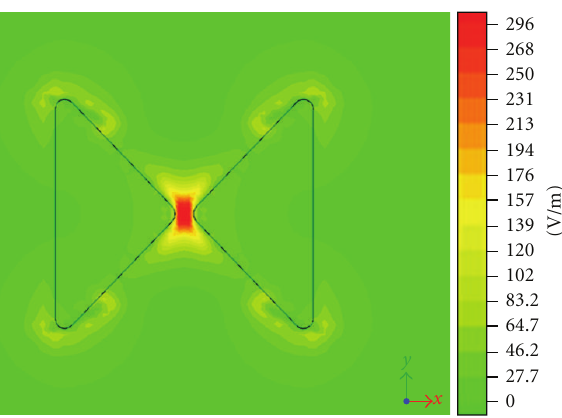
Figure 6: Electric field distribution on 90 ◦ bowtie antenna at 172.5 THz due to x -polarized plane wave incidence.